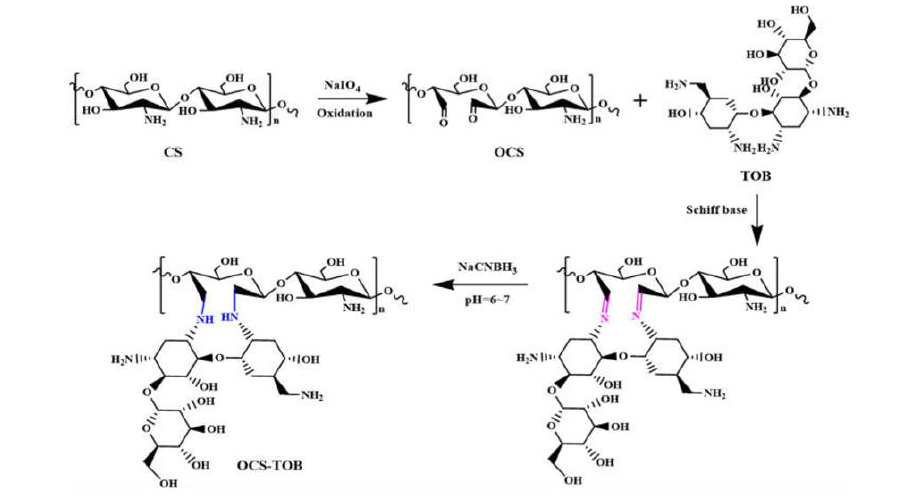
Figure 4. Synthetic pathway of oxidized chitosan (OCS) and oxidized chitosan–Tobramycin complex (OCS-TOB) [54].